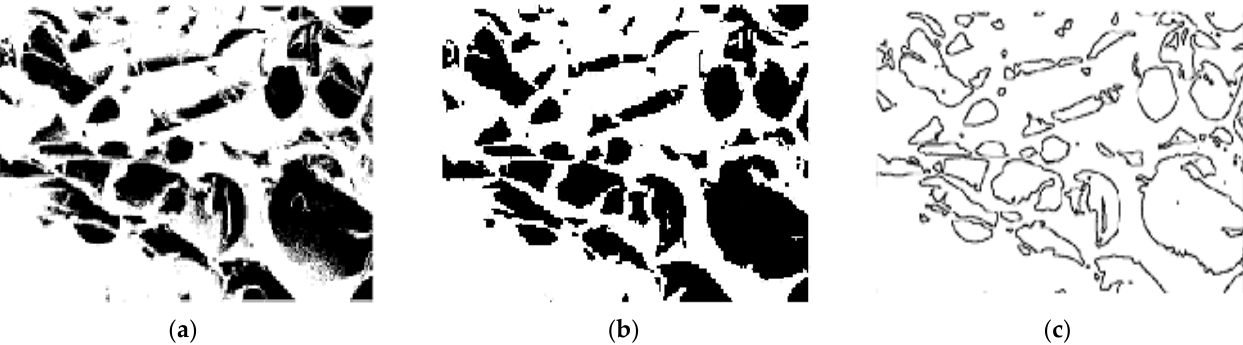
Figure 10. Segmentation by regions; image binarized without median filter ( a ), image filtred and binarized ( b ), and image segmented ( c ).